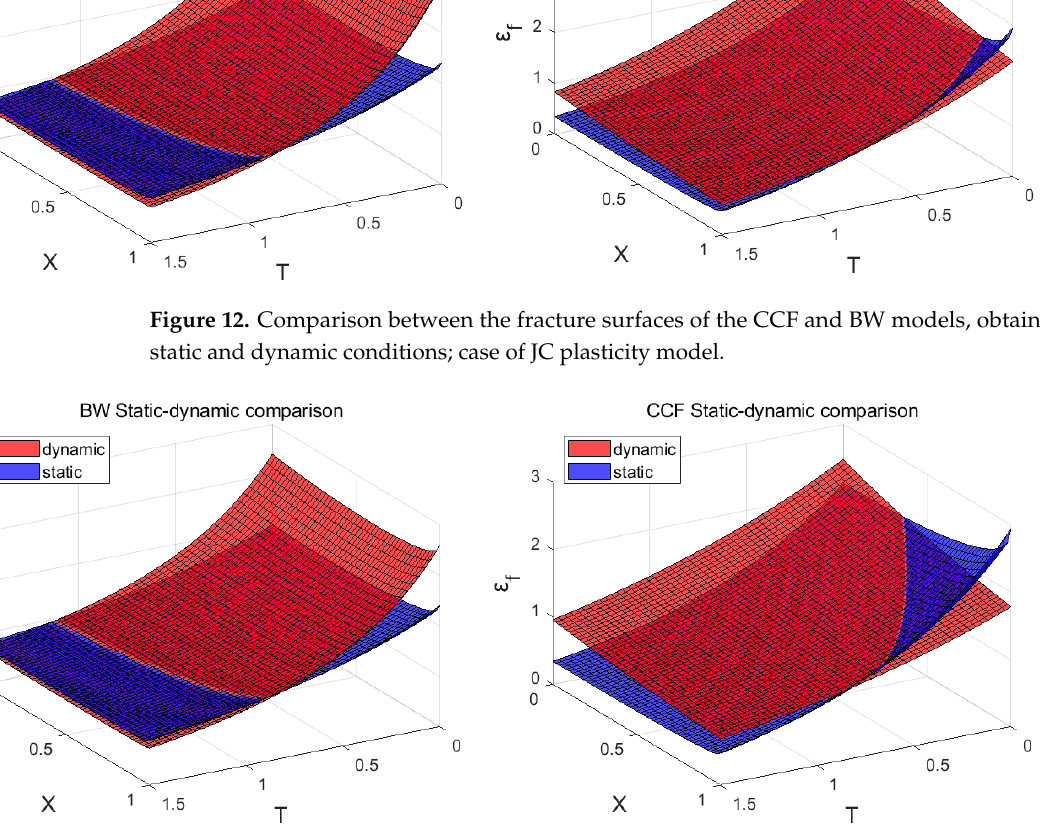
Figure 13. Comparison between the fracture surfaces of the CCF and BW models, obtained under static and dynamic conditions; case of ZA plasticity model.